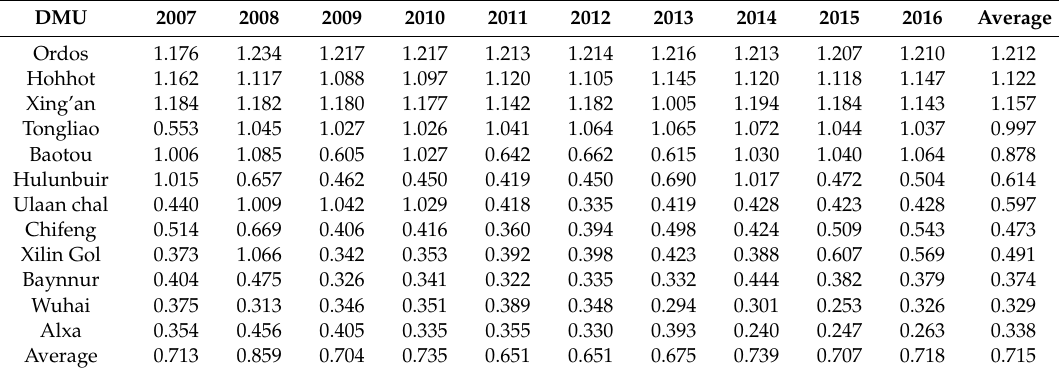
Table 2. The values of the TFP of the WEF nexus in Inner Mongolia cities from 2007 to